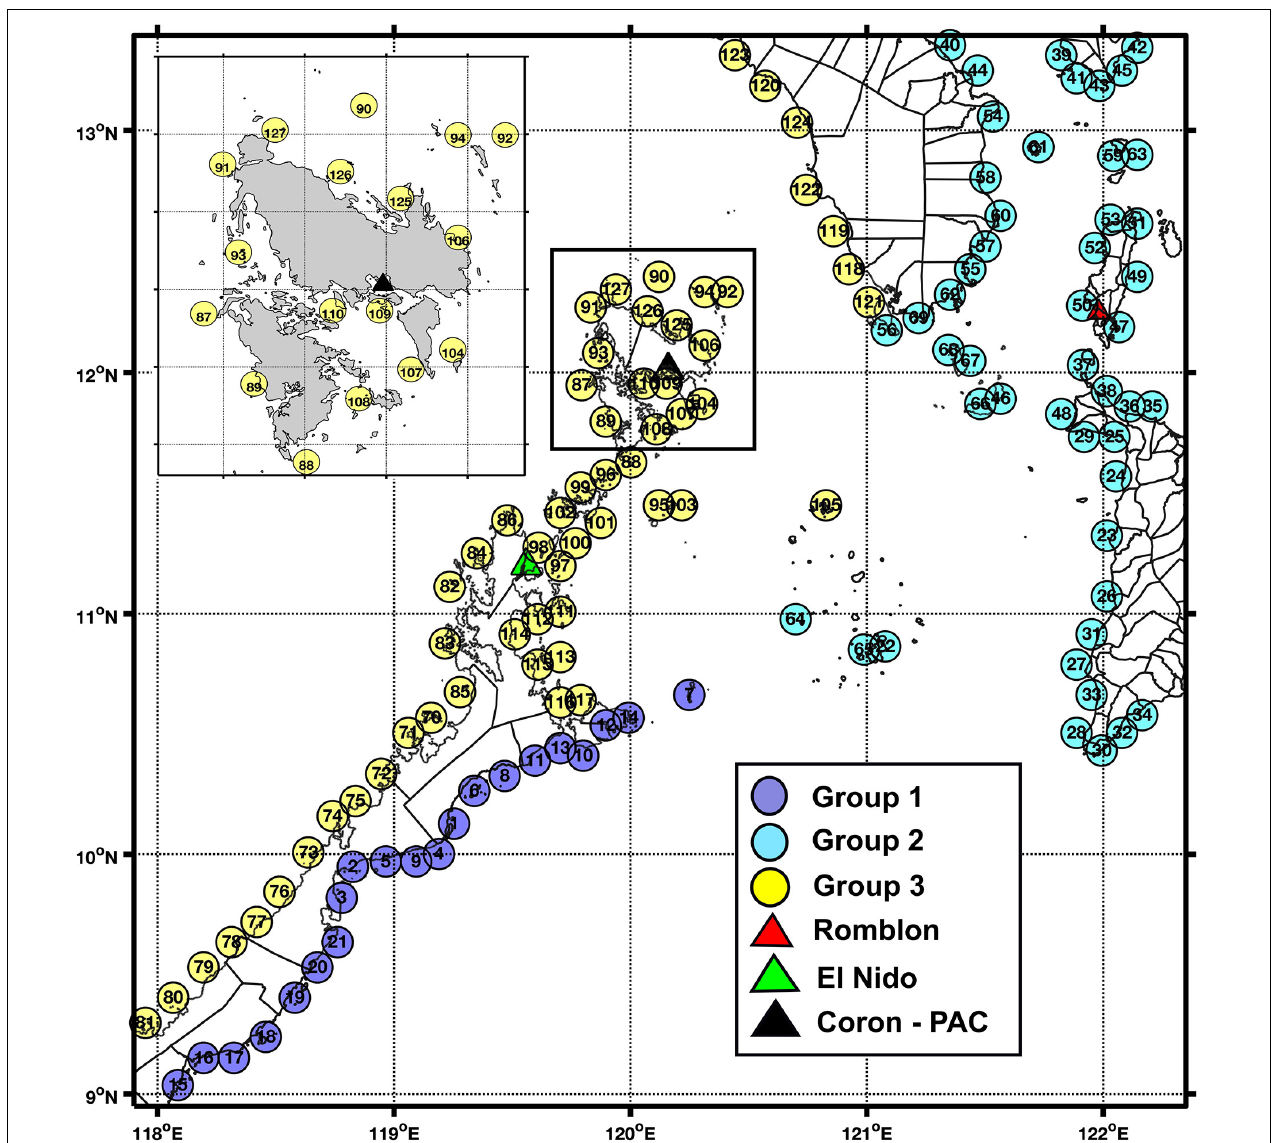
FIGURE 2 | The three provinces delineated by Infomap based on particle dispersal data for the dry-transition period. Municipal boundaries are shown on landmasses, and names per node location are listed in Supplementary Table S1 . Inset shows a close-up of locations around Coron Island. Triangles pertain to locations where samples were collected for H. scabra genetic analysis used in Ravago-Gotanco and Kim (2018), and the black triangle for their Coron sample also corresponds to the location of the Palawan Aquaculture Corporation site from Juinio-Meñez et al.